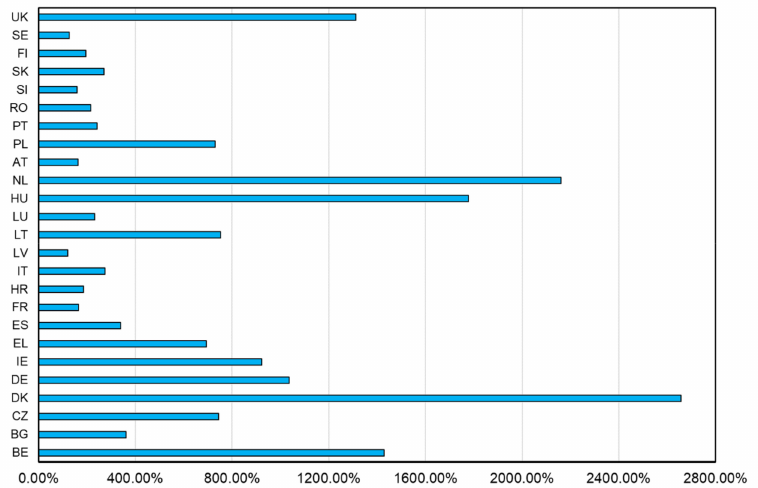
Figure 4. Percentage increase in renewable energy production in the EU countries between 1990 and 2017 (own study based on data from